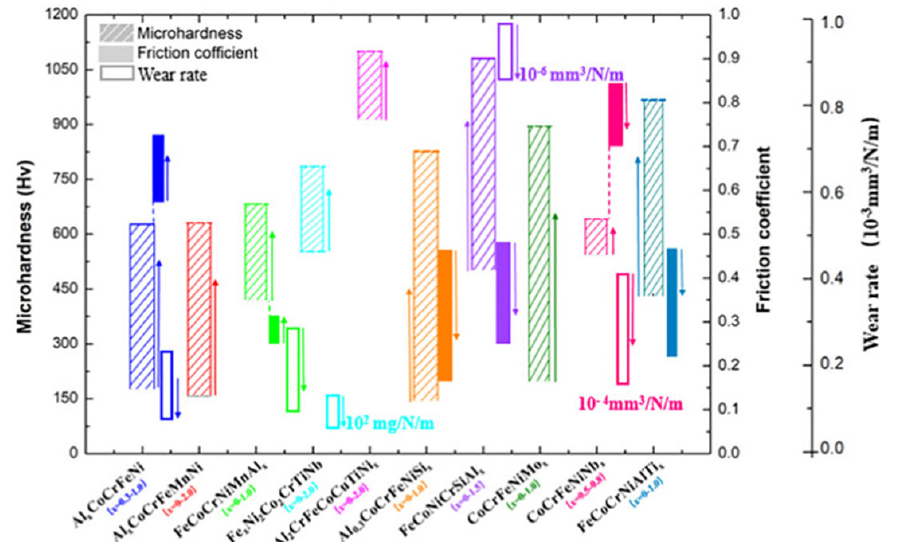
Fig. 35 Microhardness, friction coefficient, and wear rate of different HEAs [563]. Reproduced with permission from Ref. [563], © Elsevier B.V.,